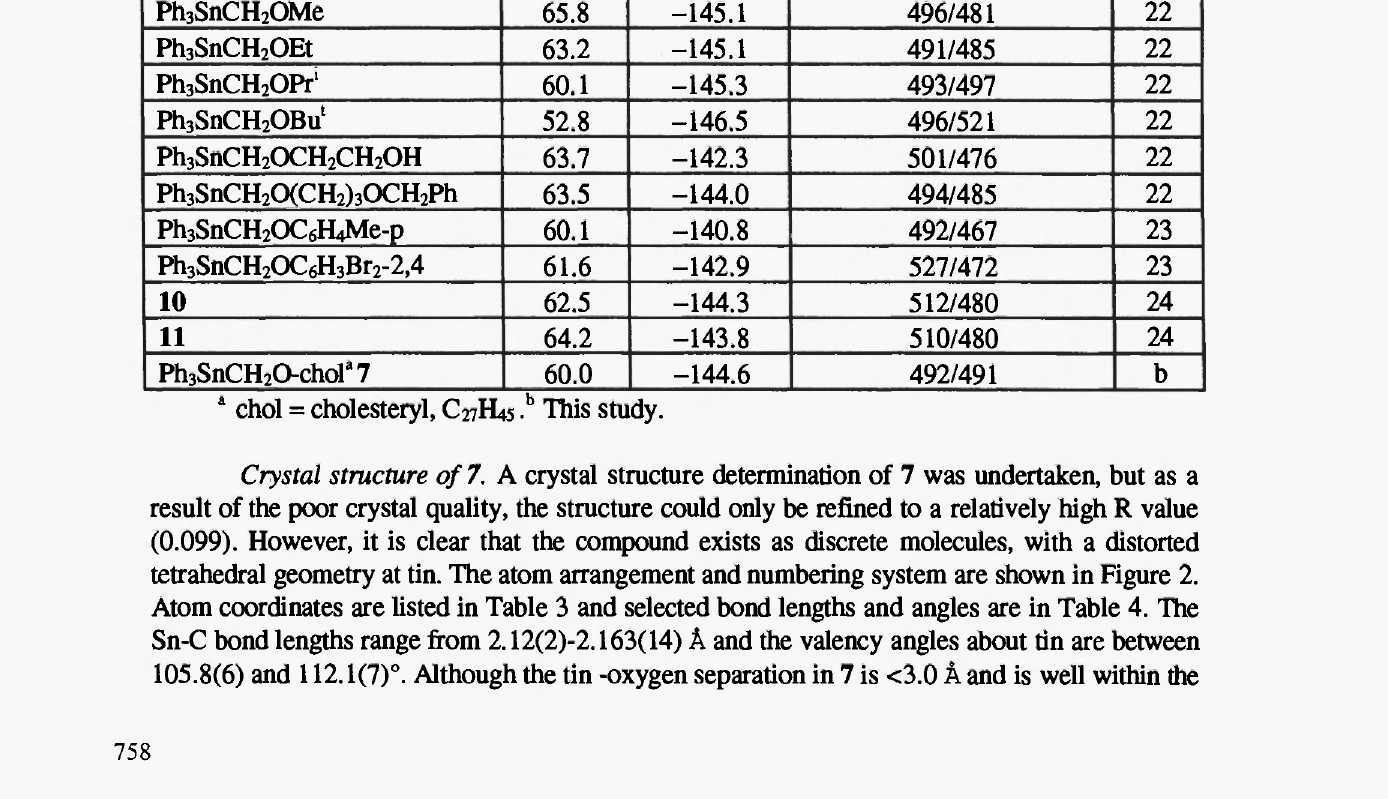
SnCH OR in CDC1 3 2